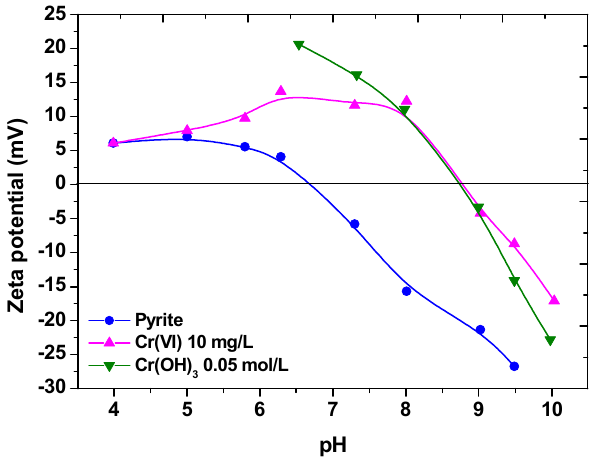
Figure 3. Zeta-potential measurements of the pyrite system (with and without the presence of 10 mg L −1 Cr(VI) and also of Cr(OH) 3 ). Reprinted with permission; copyright Elsevier [41]